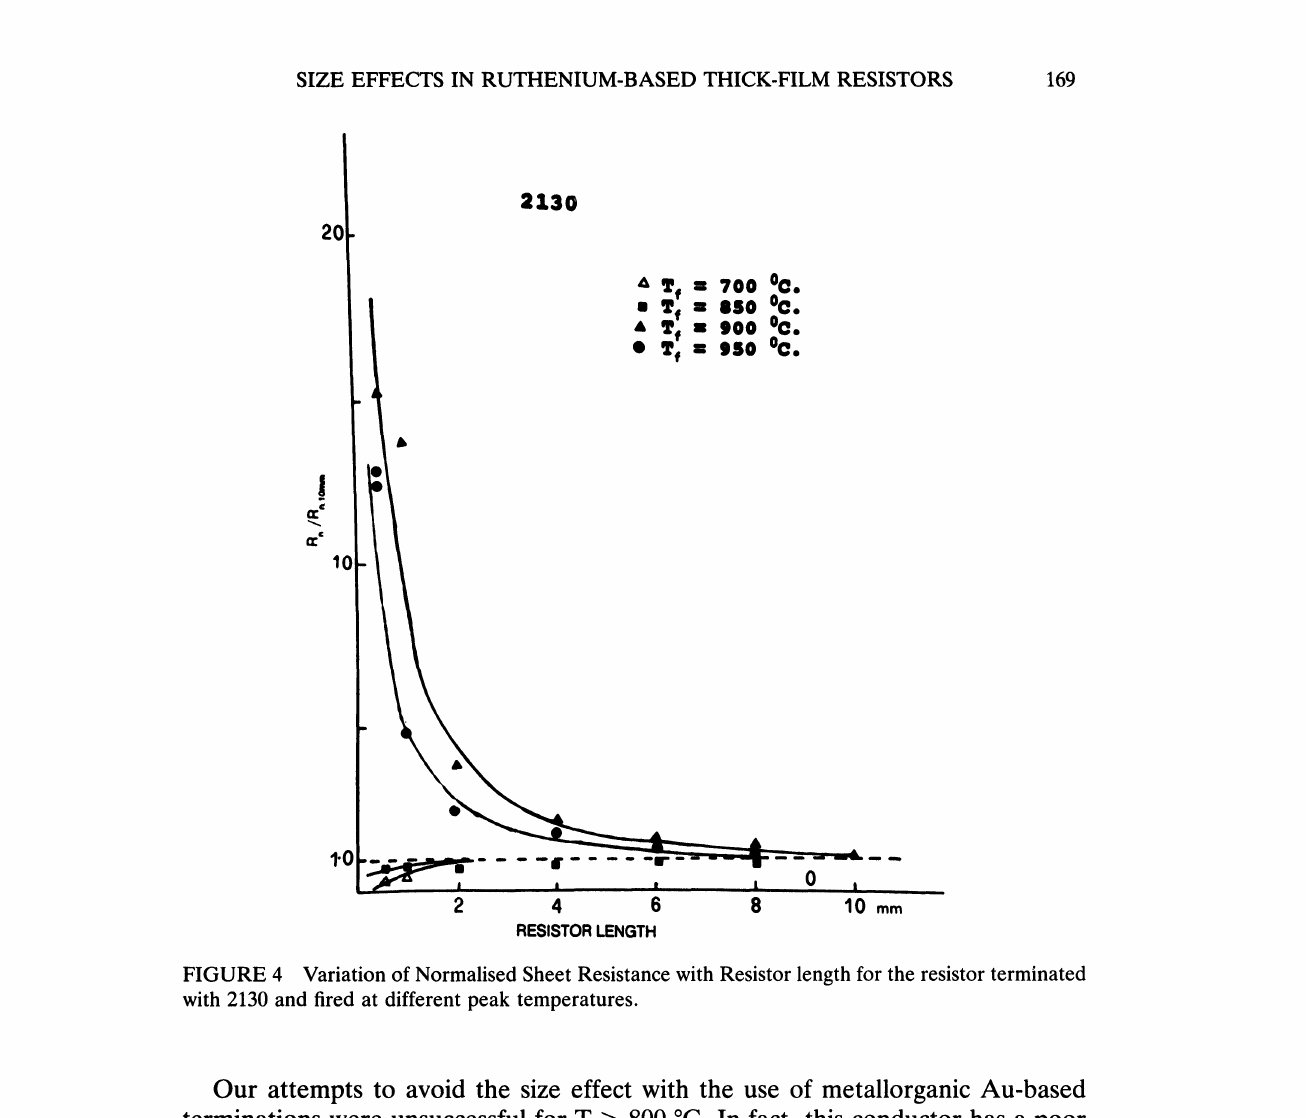
FIGURE 4 Variation of Normalised Sheet Resistance with Resistor length for the resistor terminated with 2130 and fired at different peak